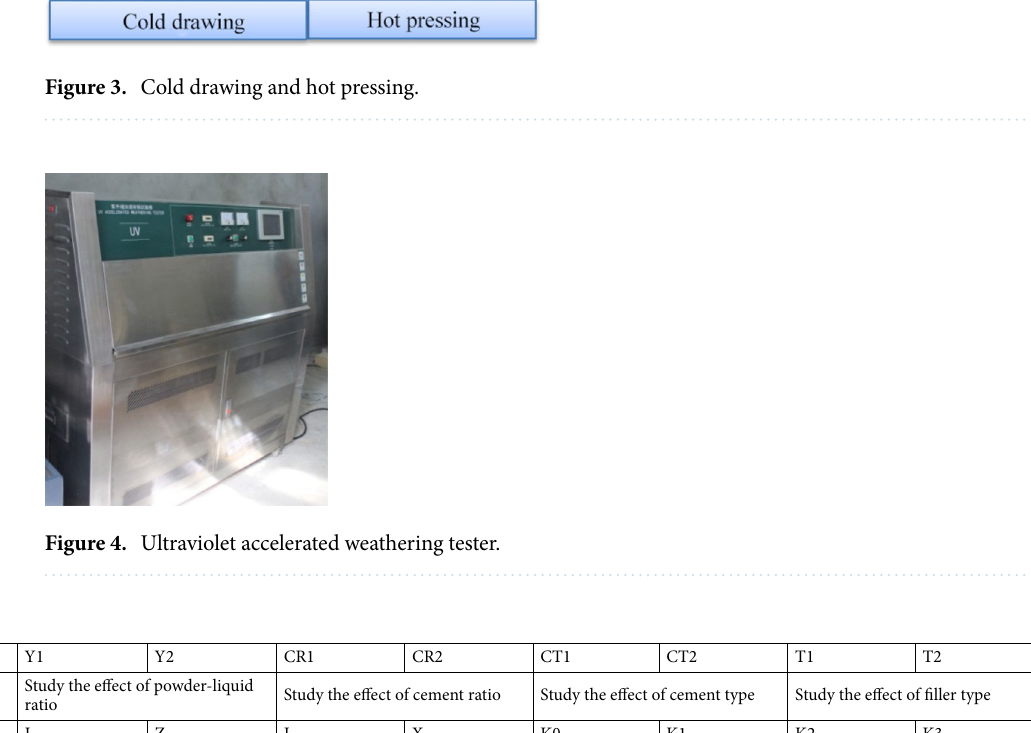
Fig. 3. The compression is discontinued after repeating this treatment six times. Wet–dry cycling treatment: Initially, the specimens in group K2 are soaked at water for 2 d, and then taken